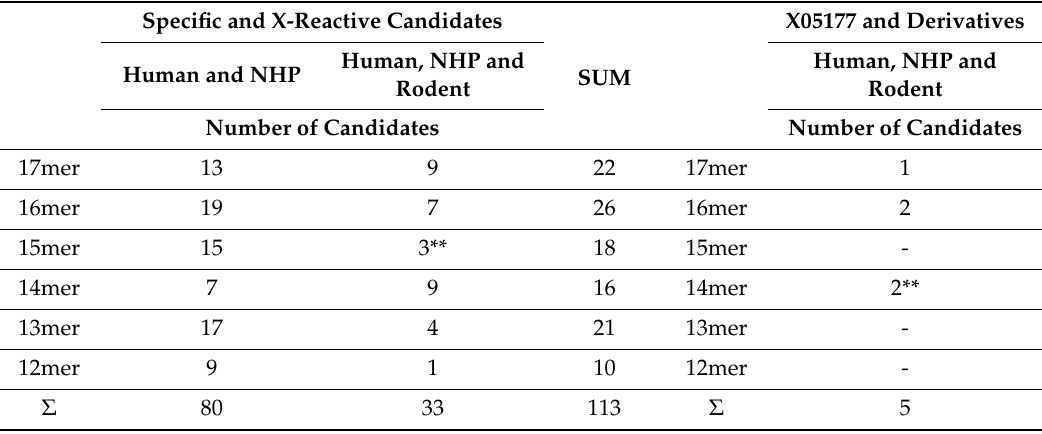
Table 1. Selected candidates for 1st in-vitro screening round. 110 sequences with 12 to 17 nucleotides were identified as potentially active sequences against TGFBR2. ** skipped sequences because of non-acceptable specificity in rodents. X05177 = historic sequence and 2 derivates served as reference but were not considered as potential active